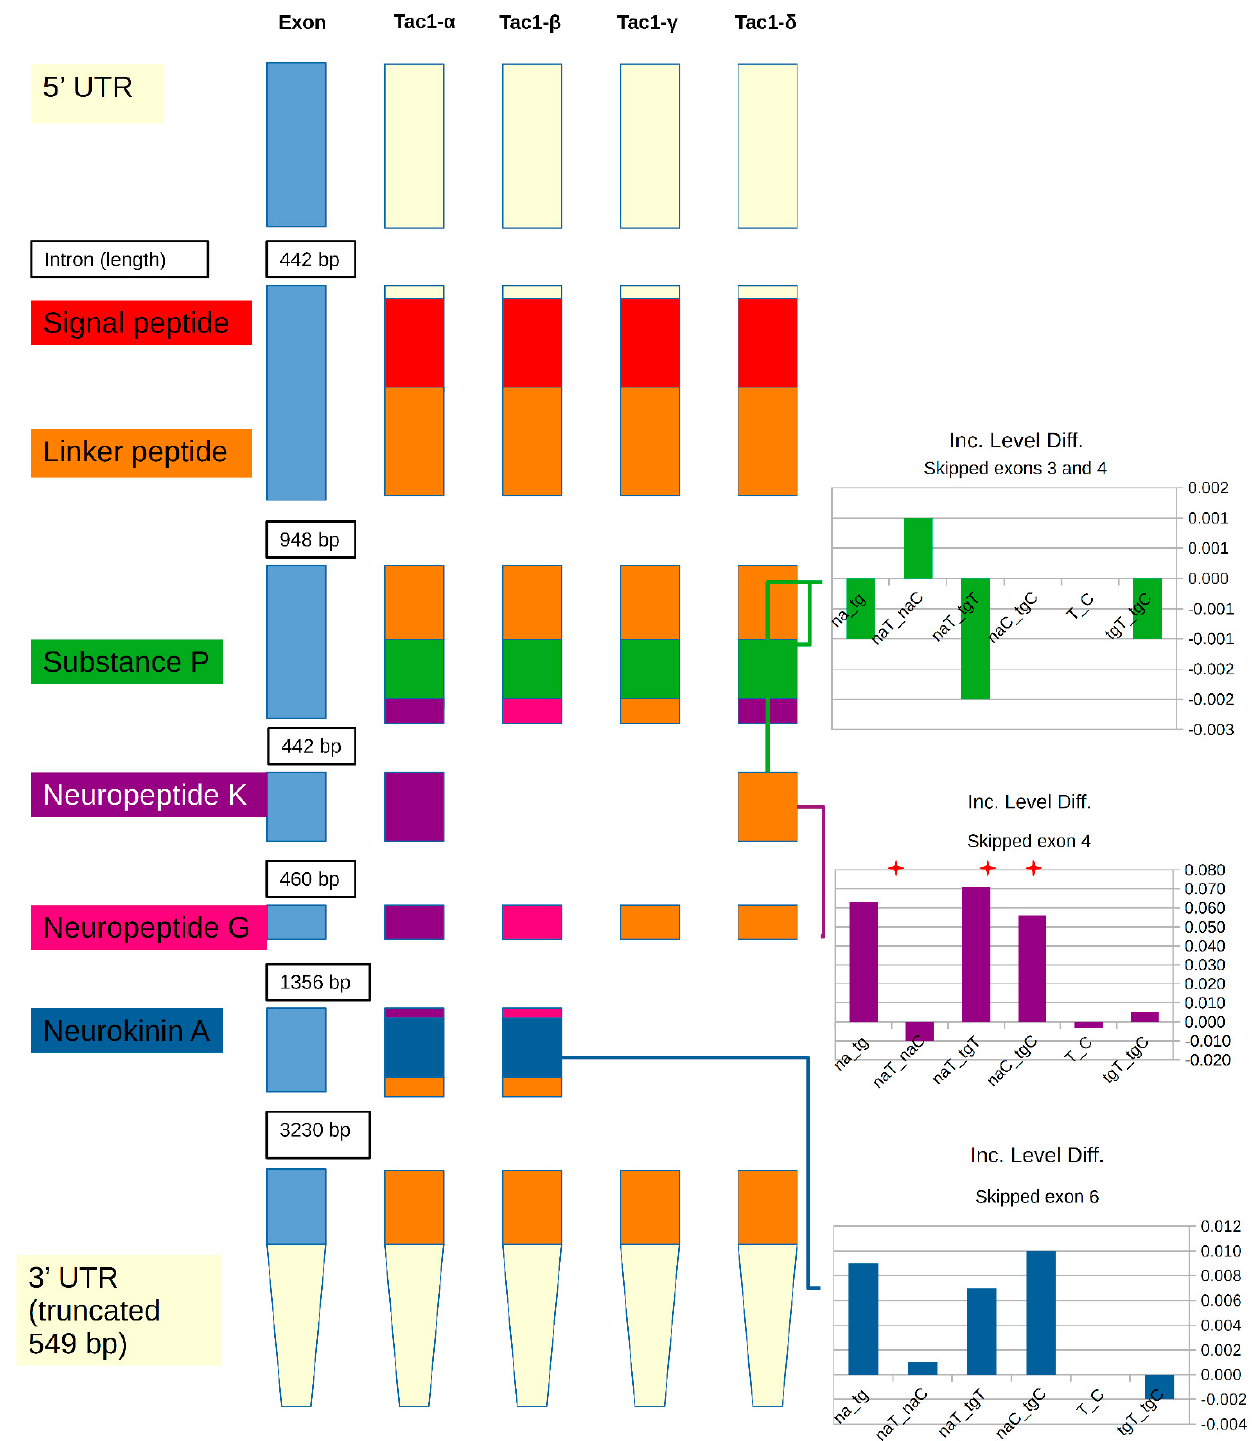
Figure 1. Schematic representation of tachykinin precursor 1 gene illustrating exons and the neuropep- tides produced from the known transcript isoforms resulting from skipped exon events. Inclusion level differences (Inc. Level Diff.) between the inclusion and exclusion of the corresponding exon are provided for different comparisons involving region (na = nucleus accumbens; tg = trigeminal ganglia) and treatment (T = nitroglycerin-treated; C = control). Within the label, the underscore sepa- rates the combinations of regions and treatments used in each comparison. Significant (FDR-adjusted p -value < 0.1) differences are denoted by the red